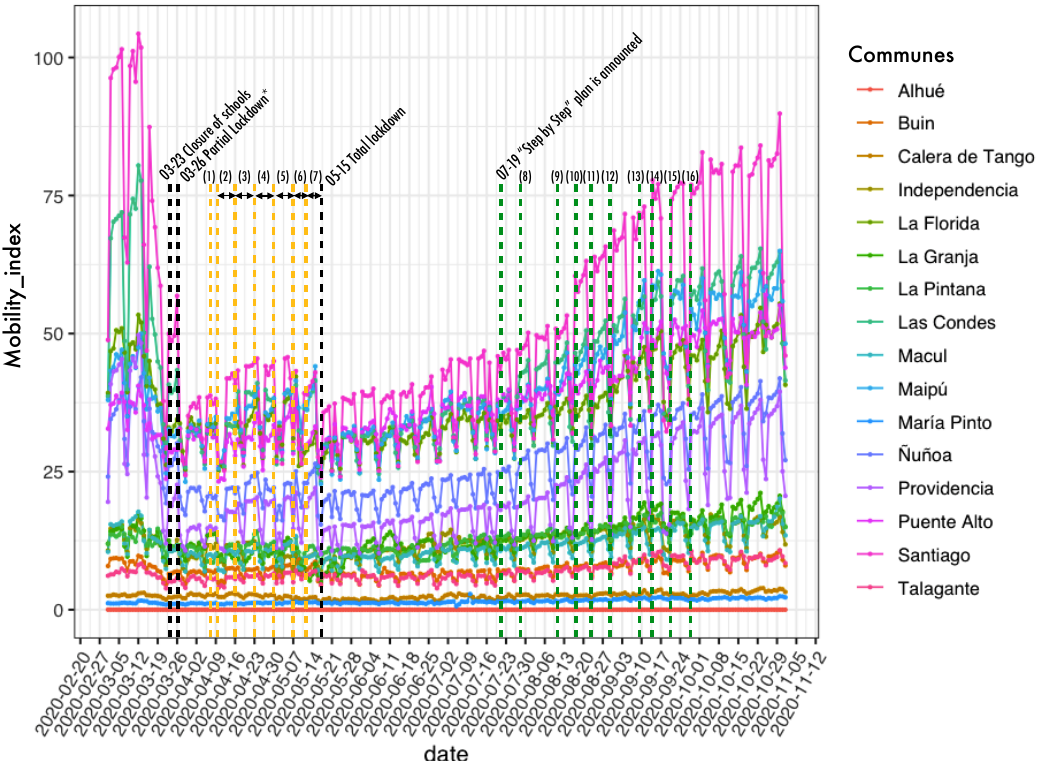
Figure 6. Time series of the mobility index for a sample of 16 MR communes in the period between 27 February 2020 and 5 November 2020. The dates corresponding to the most important confinement measures are